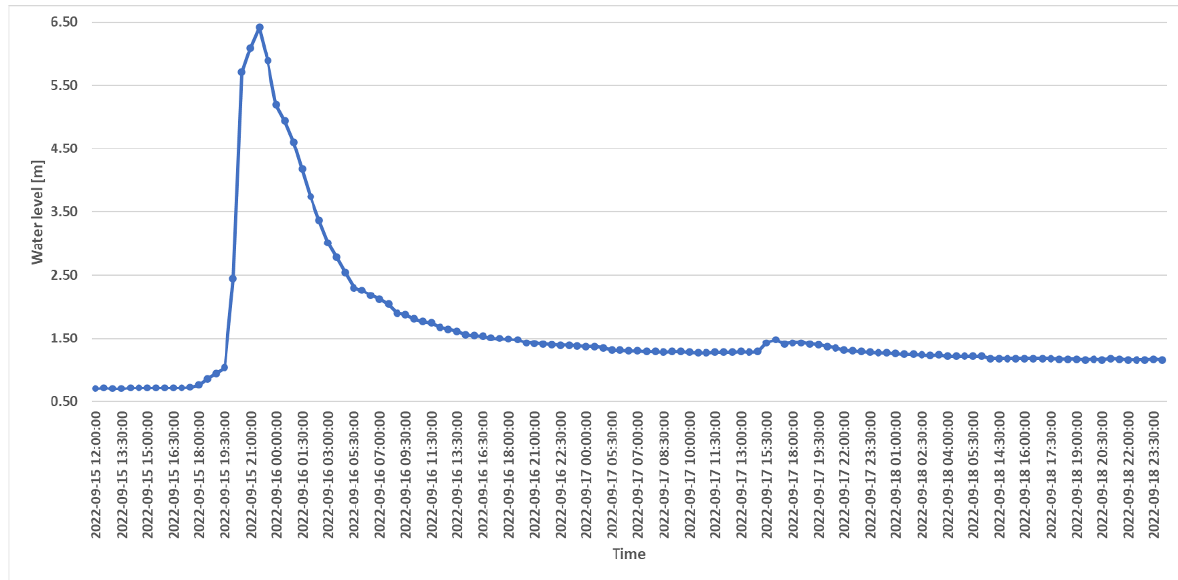
Figure 4. Water level measured at a station placed in the Brugnetto area (Misa River) between 15 September 2022 at 12:00 local time and 18 September at 24:00 local time.